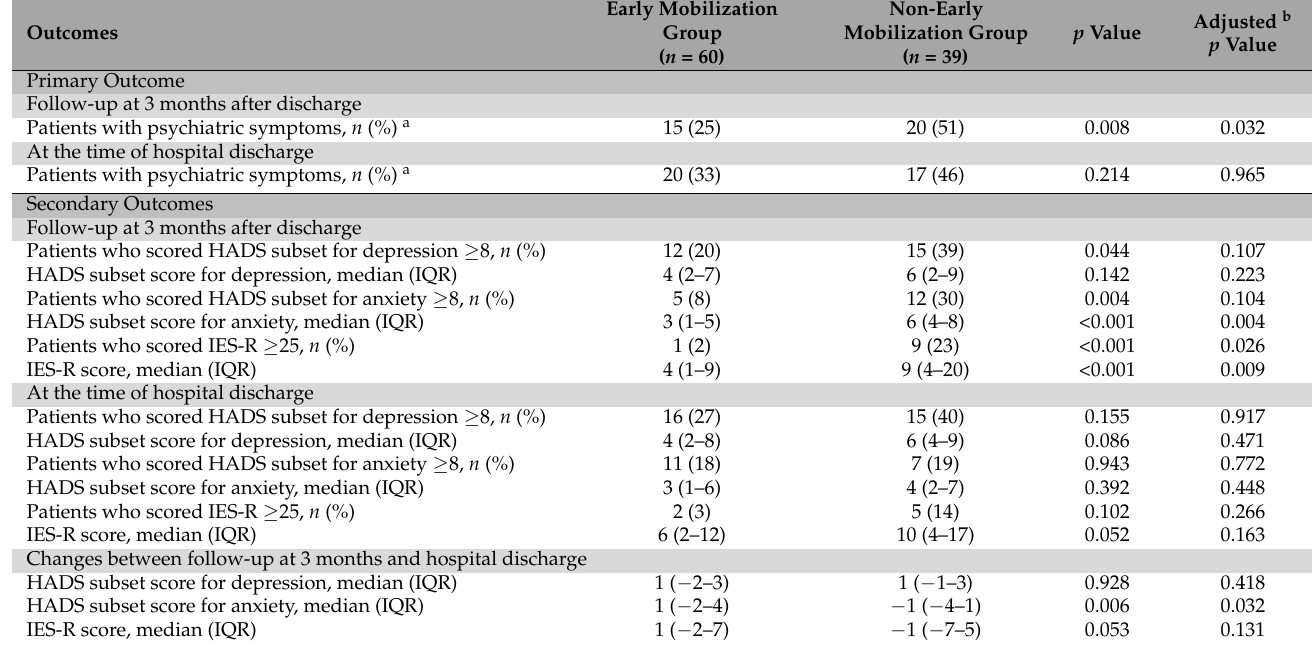
Table 2. Outcomes: psychiatric disorders in ICU survivors.